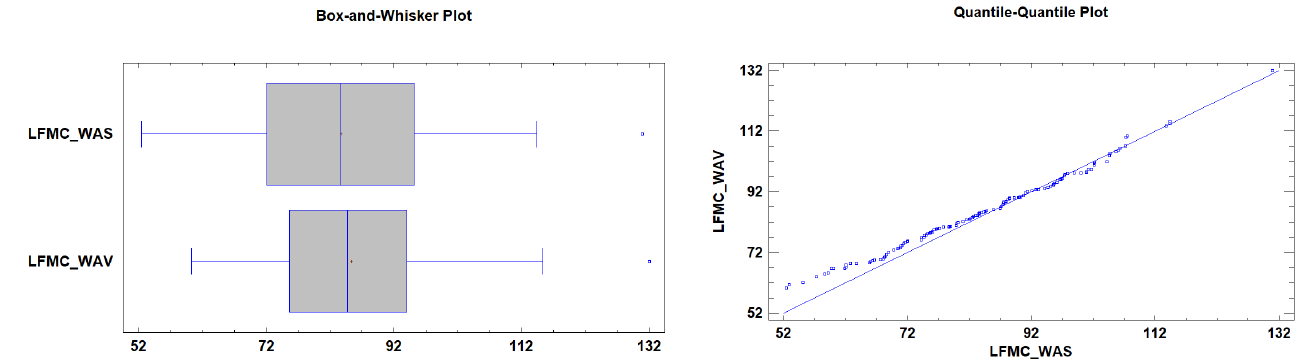
Figure 4. Comparison between LFMC_WAS (LFMC weighted average in shrubs) and LFMC_WAV (LFMC weighted average in all vegetation species).